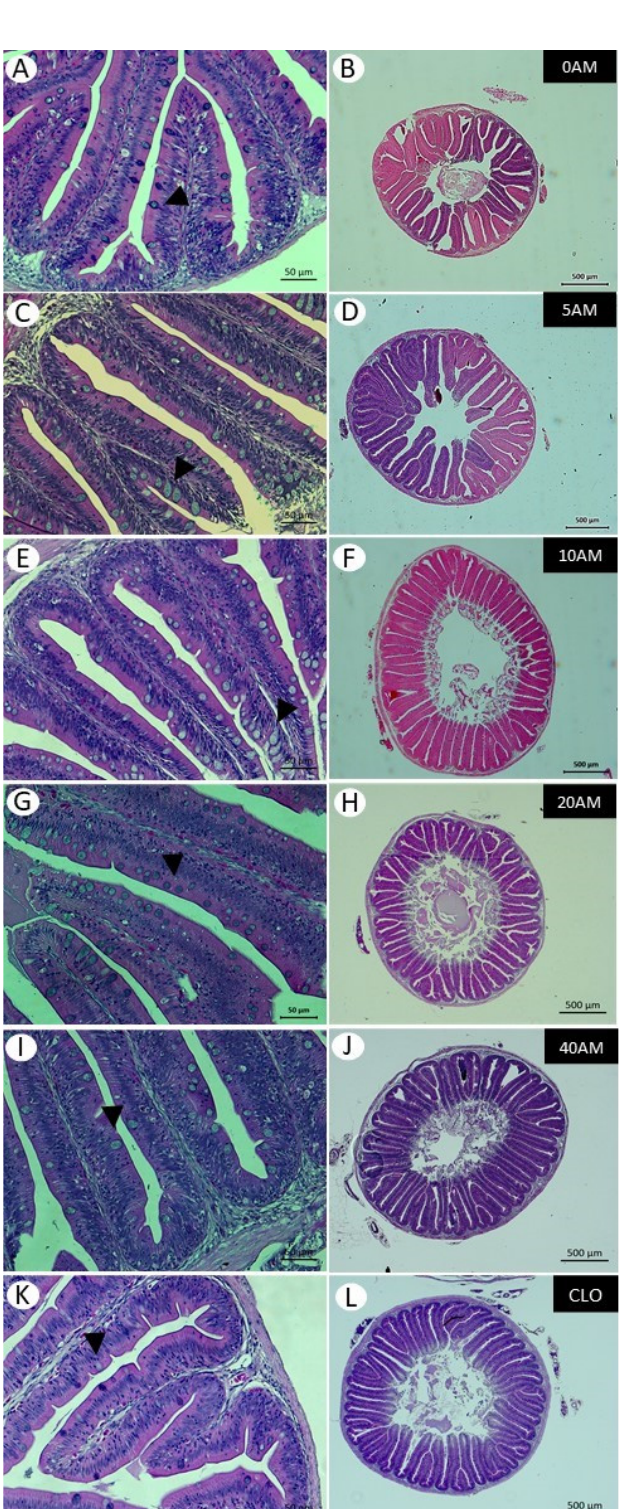
Figure 1. Histological changes in the anterior third of the intestines of juvenile Nile tilapia when fed different levels of AM or CLO, for 87 days, at 22 °C. Figures ( A , C , E , G , I , K ) represent a partial cross ‐ section of the intestine of fish fed 0AM, 5AM, 10AM, 20AM, 40AM, and CLO diets, respectively. Goblet cells are identified with the arrowhead. Bar: 50 μ m. Figures ( B , D , F , H , J , L ) represent a cross ‐ section of the whole intestine. Bar: 500 μ m. Staining: